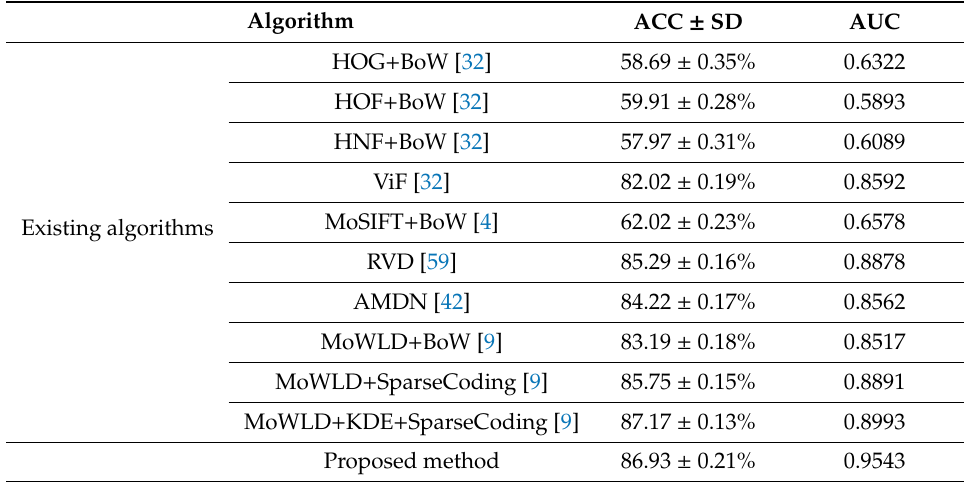
Table 2. Detection results on the BEHAVE